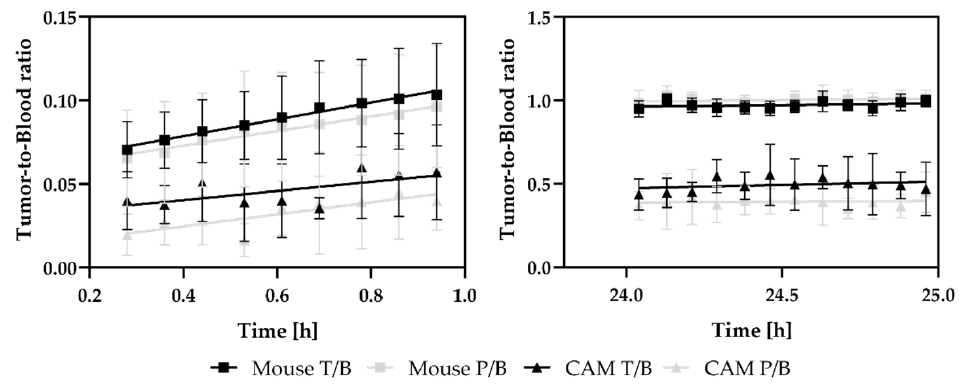
Figure 5. To investigate the accumulation dynamics of DFO-HSA, tumor-to-blood ratios (%) are calculated and plotted over time to derive the influx constant (K in ) from the slope of the line. Throughout the measurement period of 24 h, no significant differences in albumin accumulation- kinetics were detectable in the TZM-bl and PC-3 tumors, both within and in comparison, between the two xenograft models. Although the overall ration in the CAM model is lower, T/B ratios demonstrate a similar kinetic.